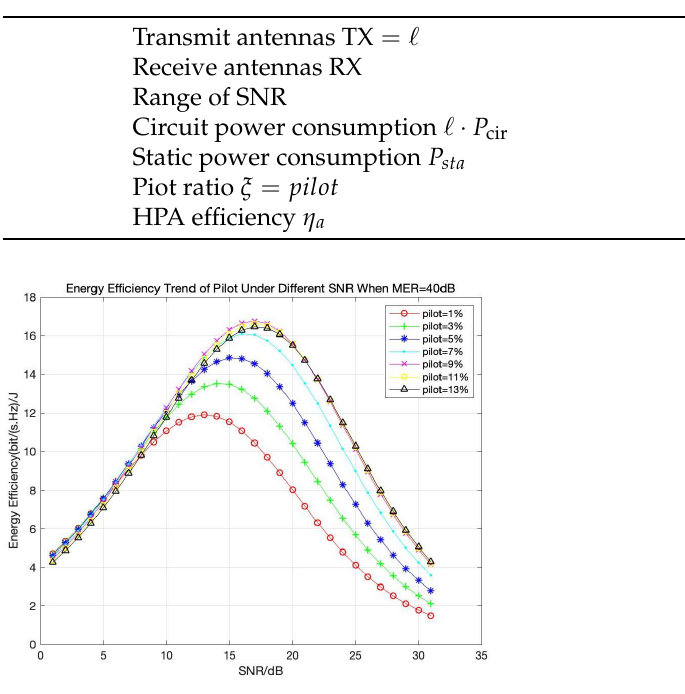
Table 4. Simulations parameters of the Rapp HPA model.